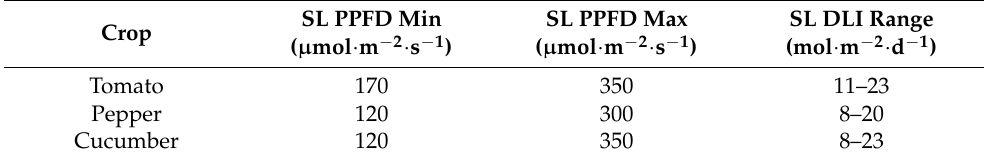
Table 6. SL PPFD min (in µ mol · m − 2 · s − 1 ), SL PPFD max (in µ mol · m − 2 · s − 1 ), and SL DLI